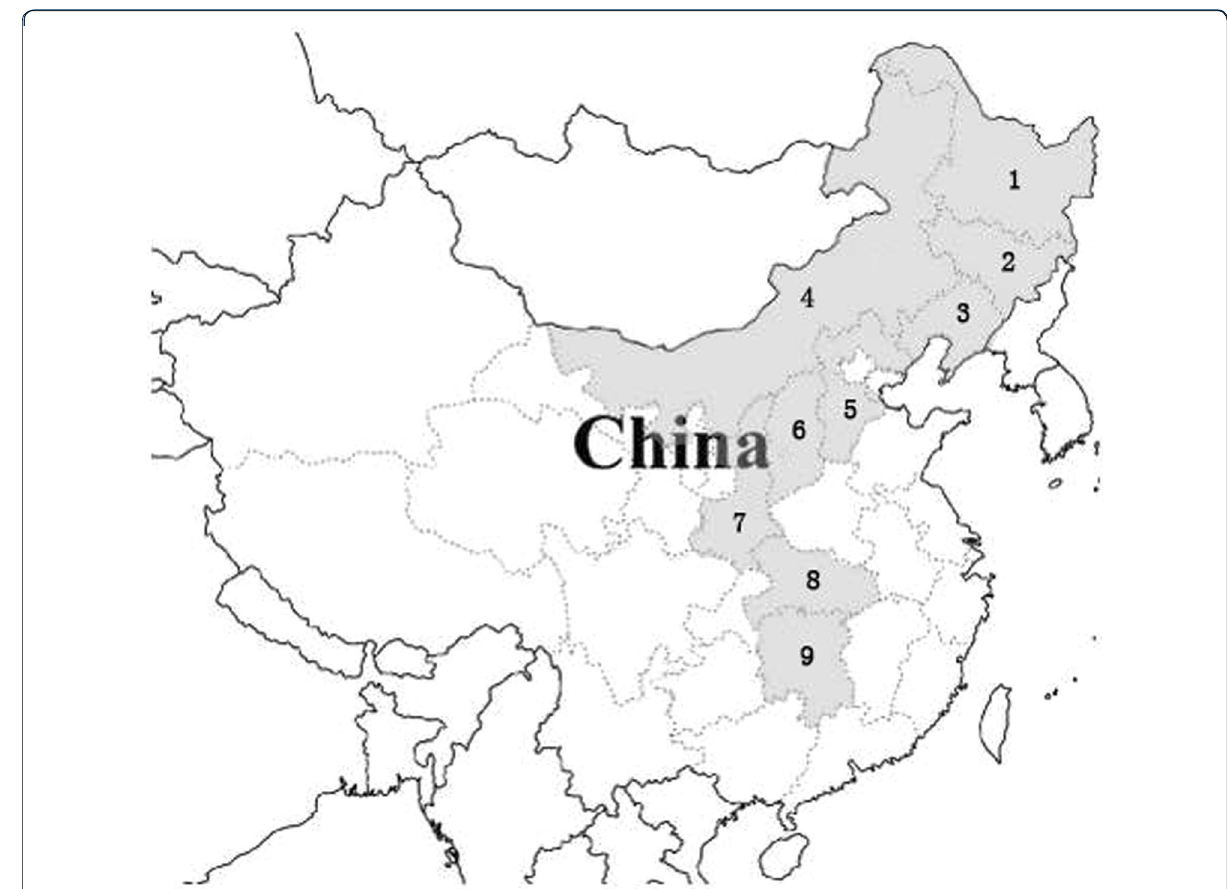
Fig. 1 Distribution of D. nipponica in China: (1) Heilongjiang, (2) Jilin, (3) Liaoning, (4) Neimenggu, (5) Hebei, (6) Shanxi, (7) Shanxi (the north of Qinling), (8) Hubei, and (9) Hunan provinces